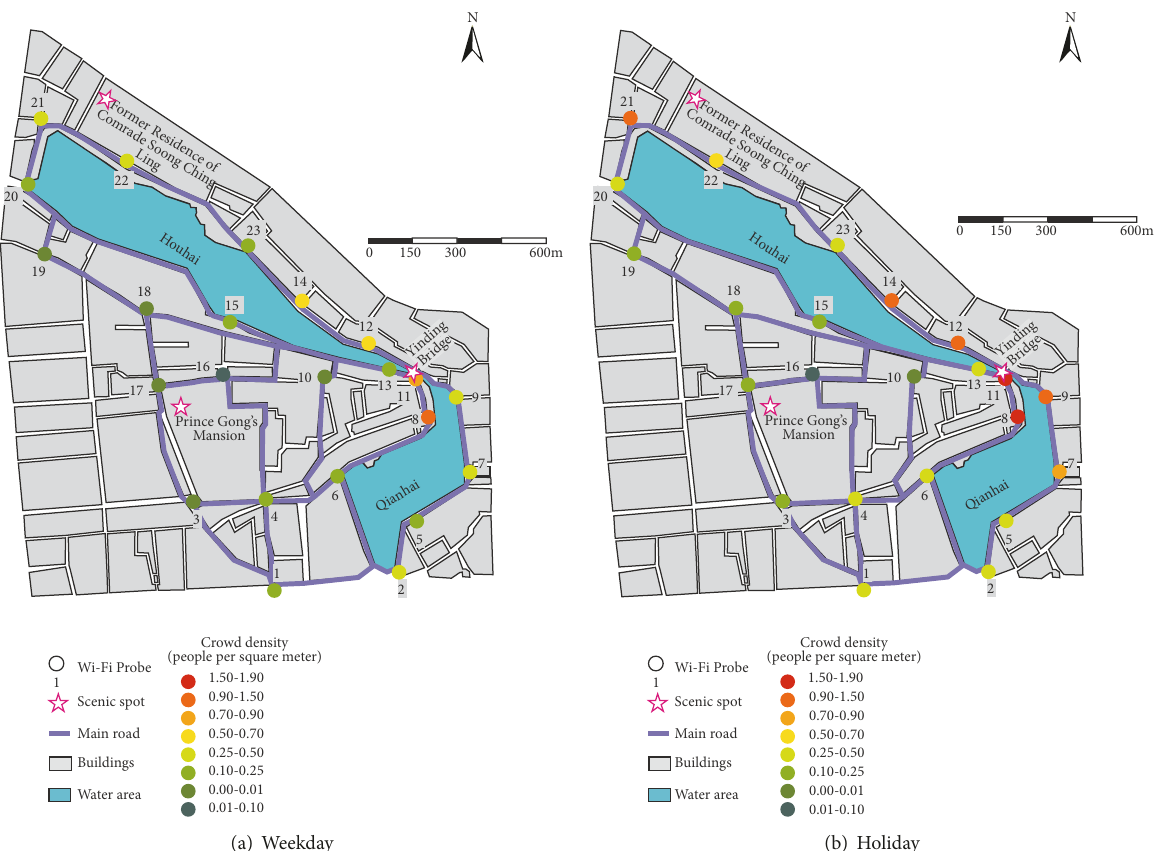
Figure 3: The locations of the installed Wi-Fi probes with the crowd density on a (a) weekday and (b) a holiday.